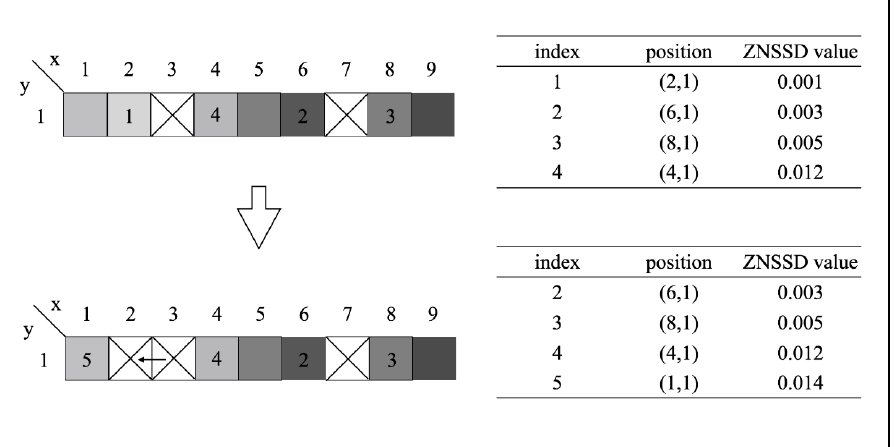
Figure 6. Schematic of modified RG-DIC based on ZNCCD.